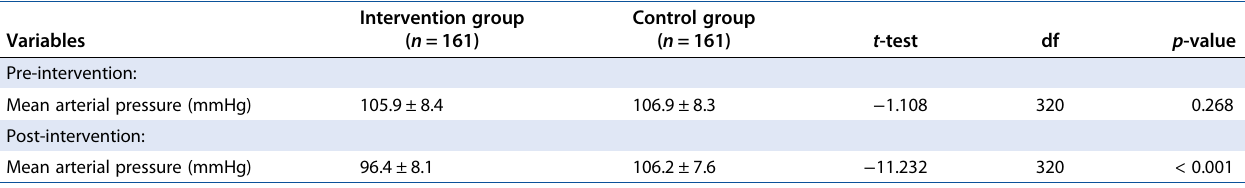
Table 4: Summary of change in mean arterial blood pressure of respondents